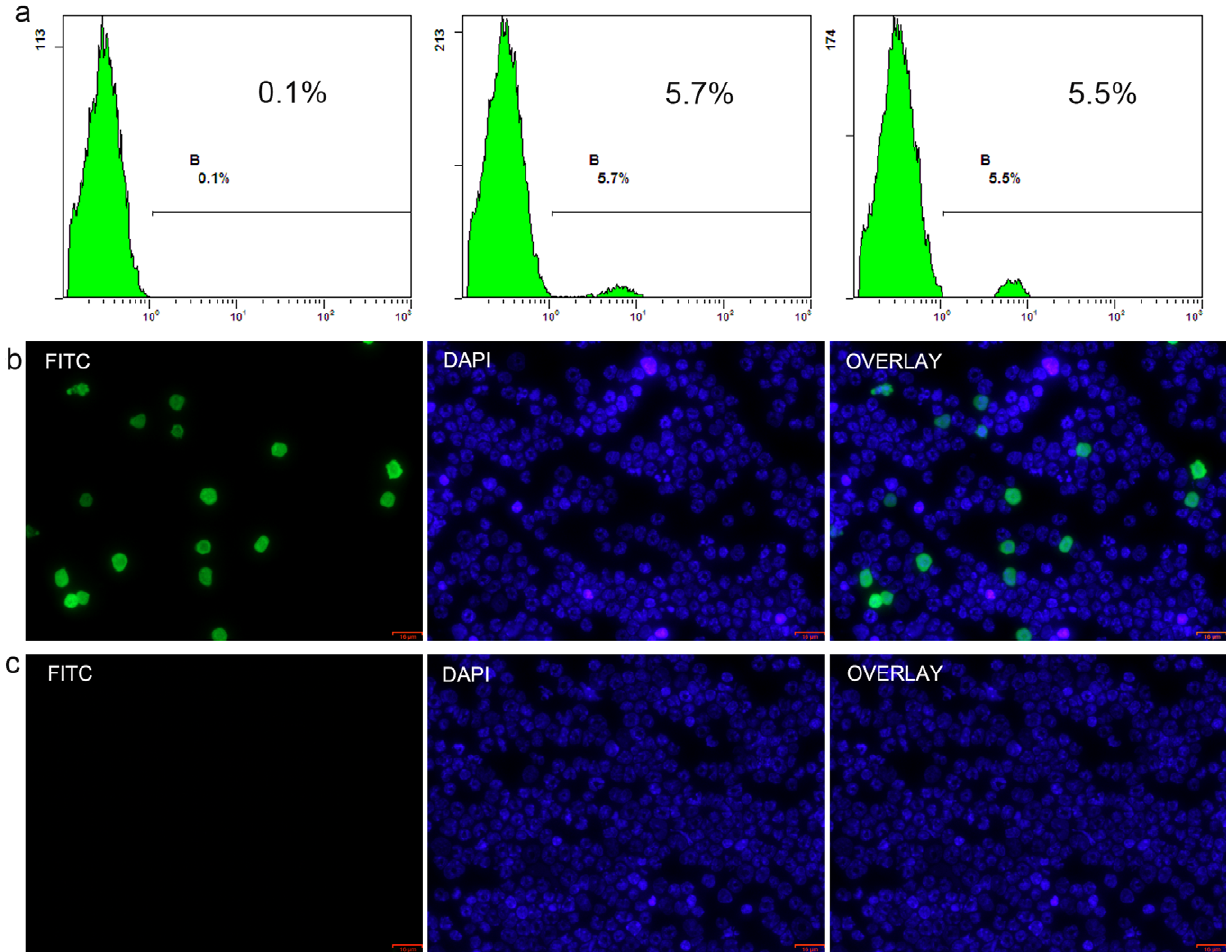
Figure 5. Flow cytometry analysis for myeloid chimerism and immunocytofluorescence staining for the presence of donor-origin cells in recipients’ innate femurs. (a)The proportion of donor-origin cells observed from 2 representative recipients at POD 30 were at 5.7% and 5.5%, respectively, with the background level assessed at 0.1%. (b, c) The presence of RT1n cells in the contralateral femurs of recipients in group 5 and their absence in other groups was confirmed by immunocytofluorescence ( 6